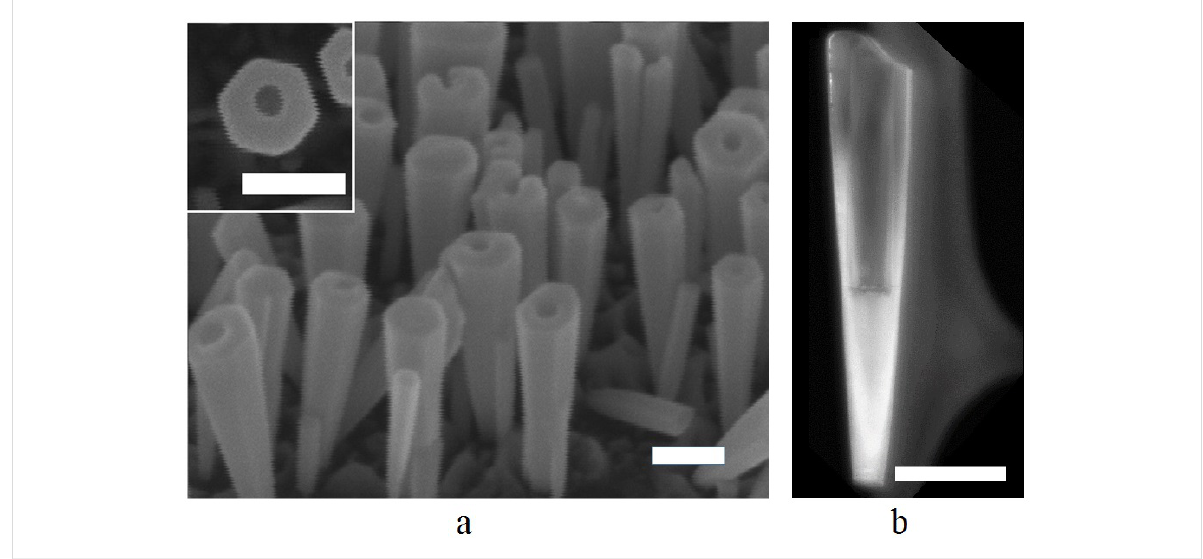
Figure 2: SEM (a) and TEM (b) images of the synthesized nanotubes. The scale bar is 100 nm.